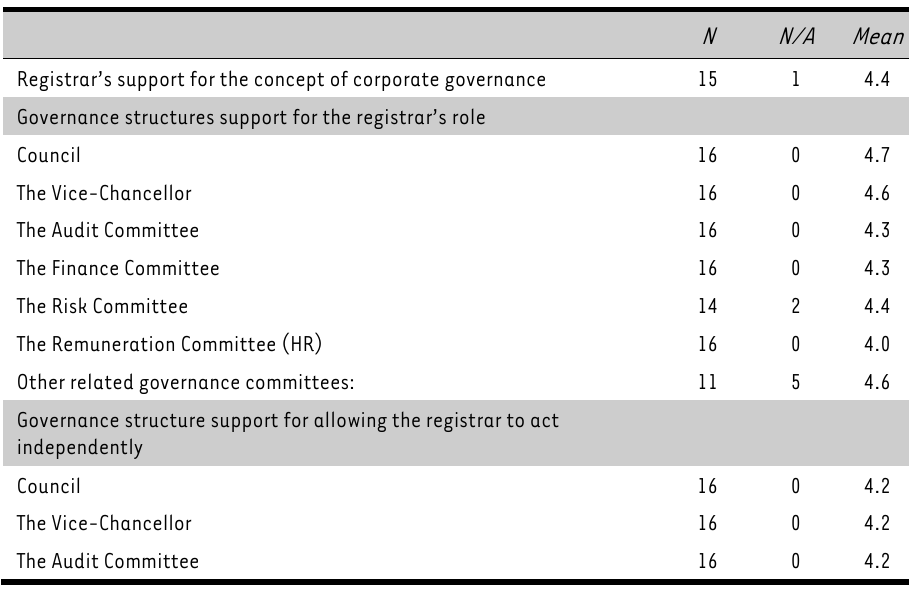
Corporate governance and the registrar